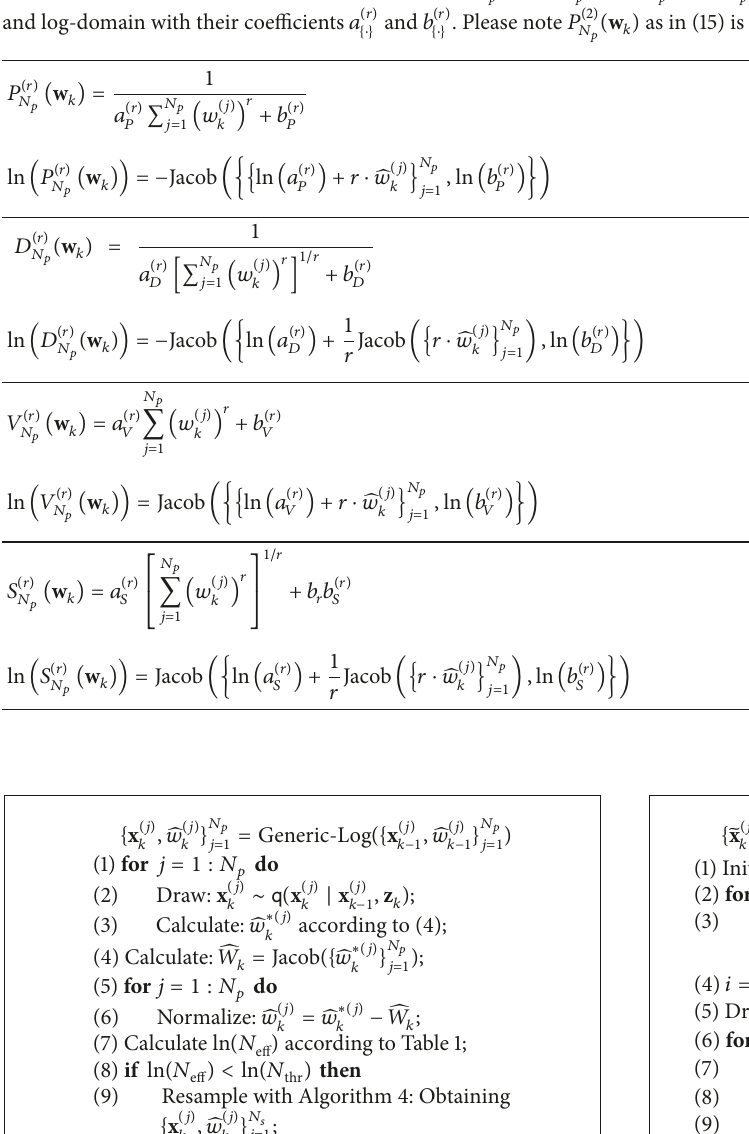
Table 1: Generalized effective sample size functions 𝑃 (𝑟) 𝑁 and log-domain with their coefficients 𝑎 (𝑟) {⋅} and 𝑏 (𝑟) {⋅} . Please note 𝑃 (2) 𝑁